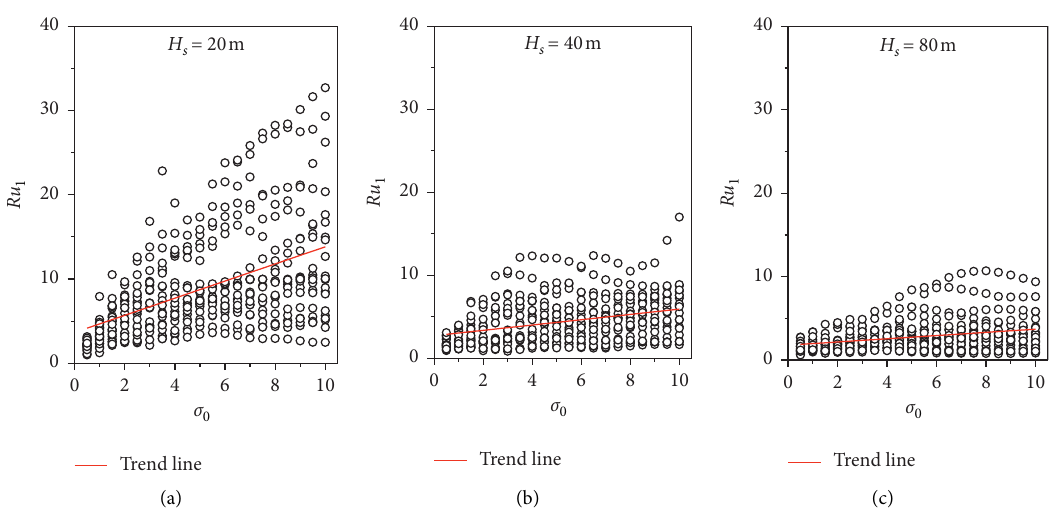
Figure 15: The parameters Ru